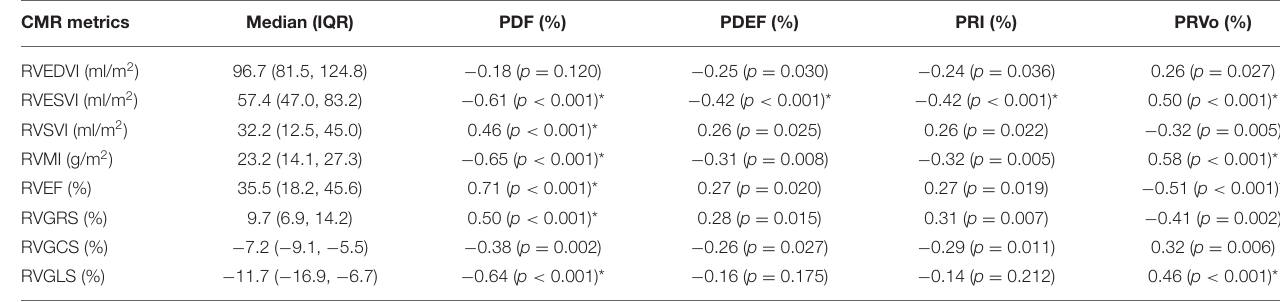
TABLE 2 | Correlation of right ventricular flow components with functional